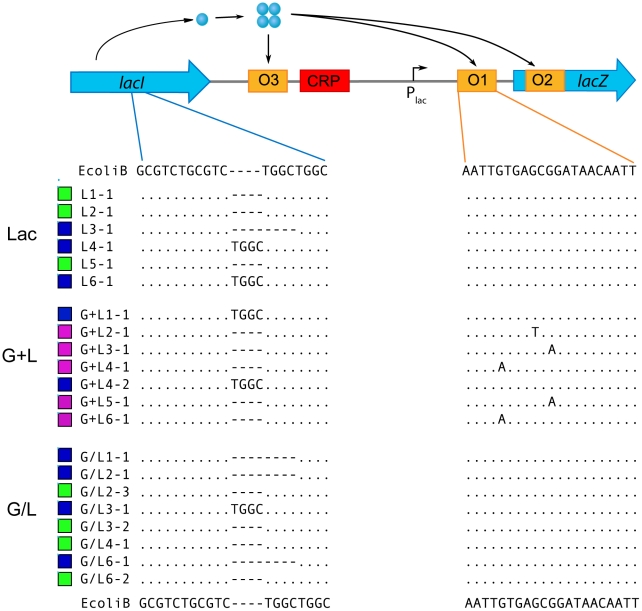
Identification lac mutations in evolved clones.Sequence alignments for evolved clones relative to the ancestor are shown for the lacI mutation hotspot region (left) and the primary lacO1 operator (right). Clones were chosen that represent the diversity in lac genotypes within each population. Colored boxes by sequences indicate the inducer response type for each clone. Bimodal is shown as green, constitutive is shown as blue and lower threshold response is shown as purple. No sequence was obtained for the G/L5 clones. Sequence alignments are not shown for Glu clones since all have wt lac regulatory sequences.